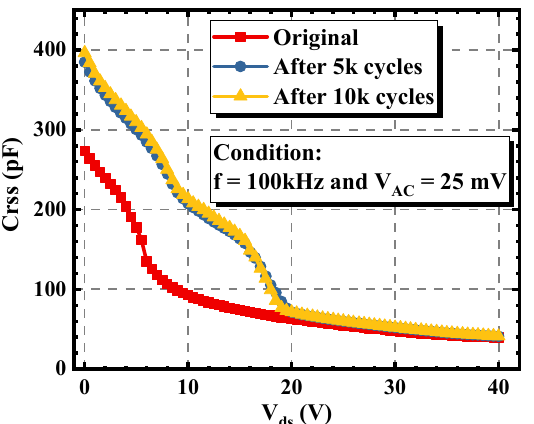
Figure 9. Variations of the C gd of the double-trench SiC MOSFET under different avalanche stress cycles .